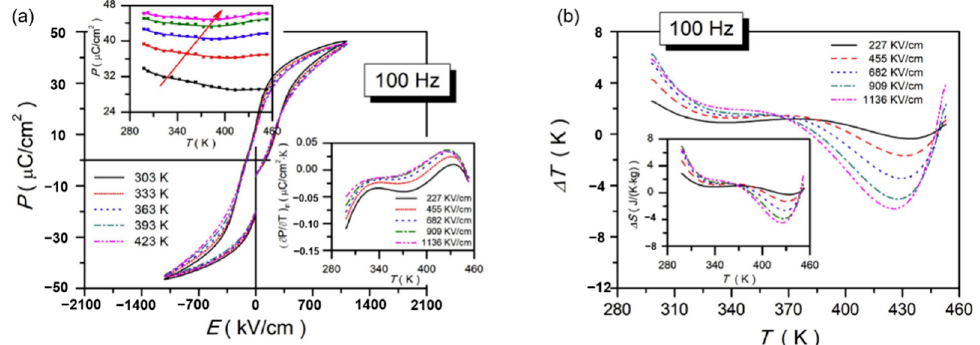
Figure 30. P-E loops and the corresponding Δ T ( T ) of the Nb-doped PZST thin film. ( a , b ) at 100 Hz. Insets in ( a ): P ( T ) (left upper corner) and ( ∂ P / ∂ T )( T ) (right lower corner) at selected electric fields. Insets in ( b ): Δ S ( T ). Reprinted with permission from [107]. Copyright 2019 Elsevier Ltd. and Techna Group S.r.l. Table 1. Comparison of EC refrigeration of different thin films.